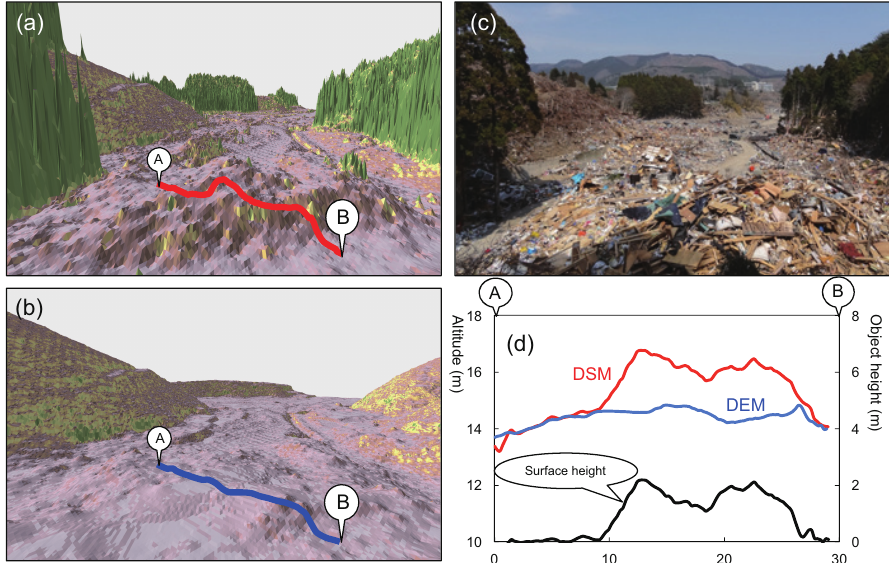
Figure 7. Three-dimensional mapping of the tsunami debris using Light Detection And Ranging (LiDAR) and optical satellite remote sensing [76]. ( a ) Digital Surface Model (DSM), ( b ) Digital Surface Elevation Model (DEM), ( c ) Tsunami debris distribution observed in the field, and ( d ) Estimated height of the tsunami debris.